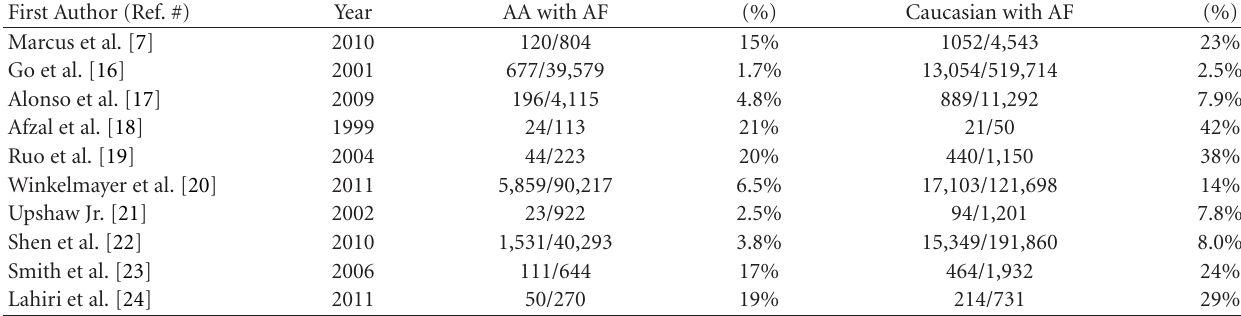
Table 3: Prevalence of atrial fibrillation among African American and Caucasians in included